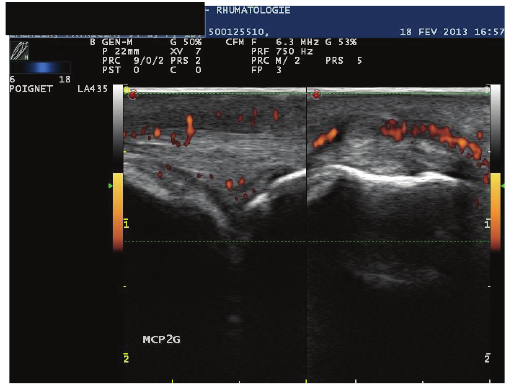
Figure 1: Active synovitis and dorsal tenosynovitis of the second left metacarpophalangeal joint in a 54-year-old woman with relapsing- remitting multiple sclerosis treated by IFN- 𝛽